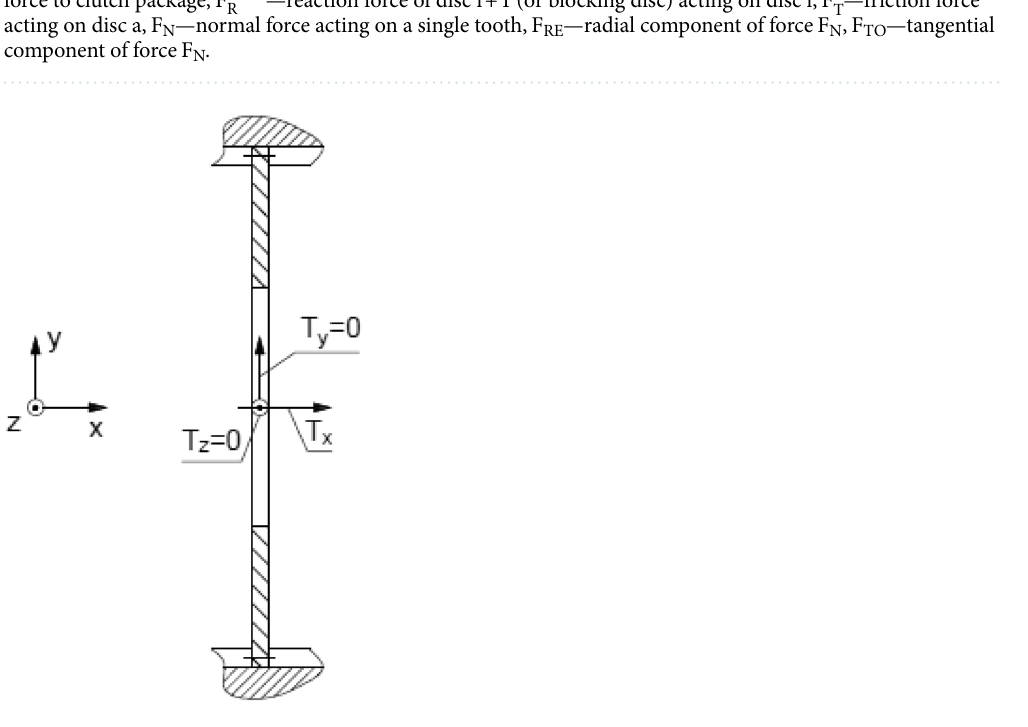
Figure 4. Distribution of moments acting on a single disc with external spline